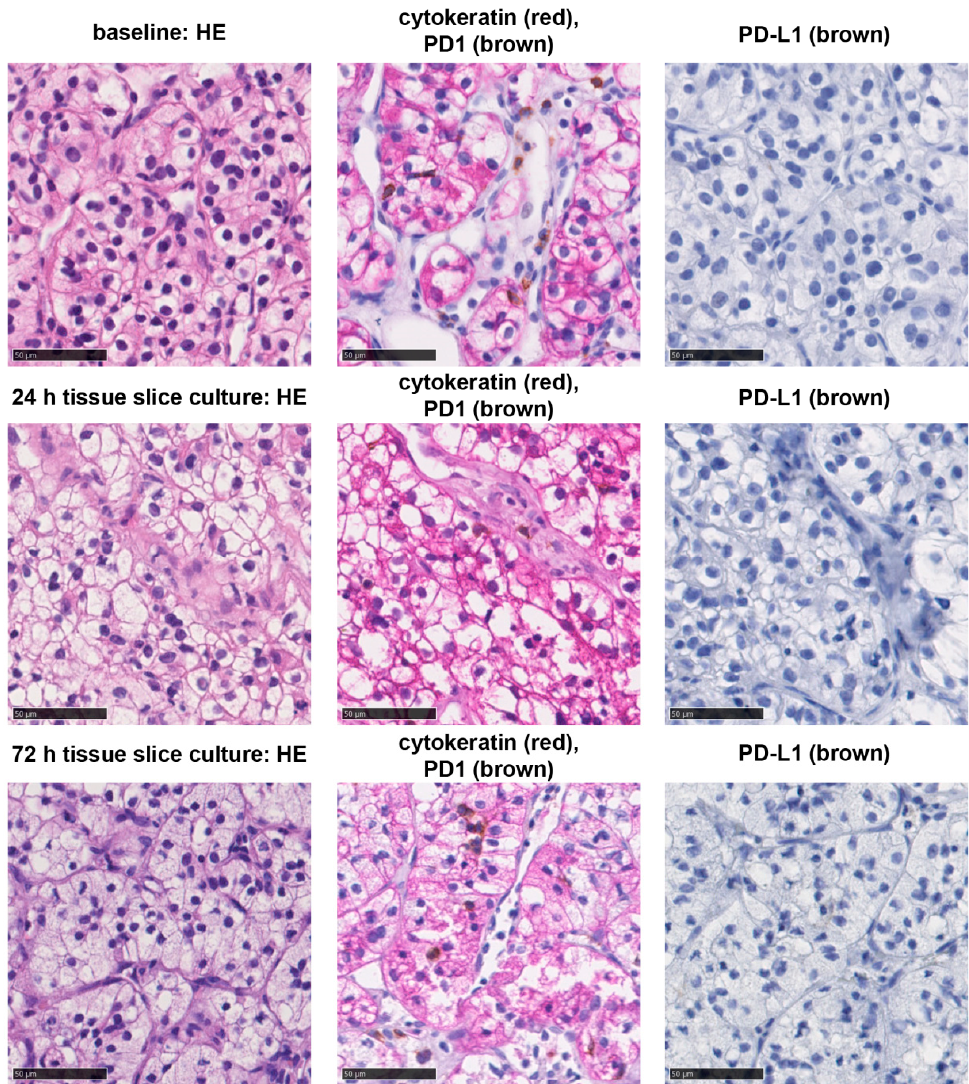
Figure 2. Histological morphology and PD-1/PD-L1 status of tumors. Clear cell morphology of tumors (HE-staining, left), PD1+ immune cells (brown) in the tumor tissue (red) (middle), and PD-L1 expression (brown) at baseline and after tissue slice culture for 24 h or 72 h. Interspersed PD1+ immune cells were present, however the tumor cells showed no PD-L1 expression. Bar indicates 50 µm.